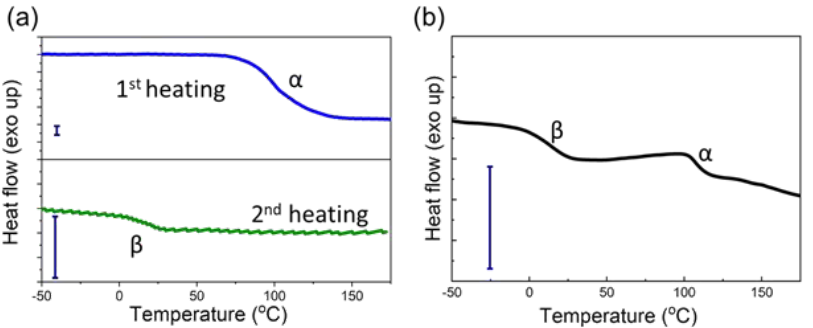
Figure 1. DSC profiles of PDEF with different thermal histories. ( a ) The sample was quenched from 180 ◦ C. While mainly α relaxation is observed in the first heating, β relaxation was exclusively observed in the second heating. ( b ) The sample was quenched from 150 ◦ C. Two thermal anomalies corresponding to α relaxation and β relaxation can be